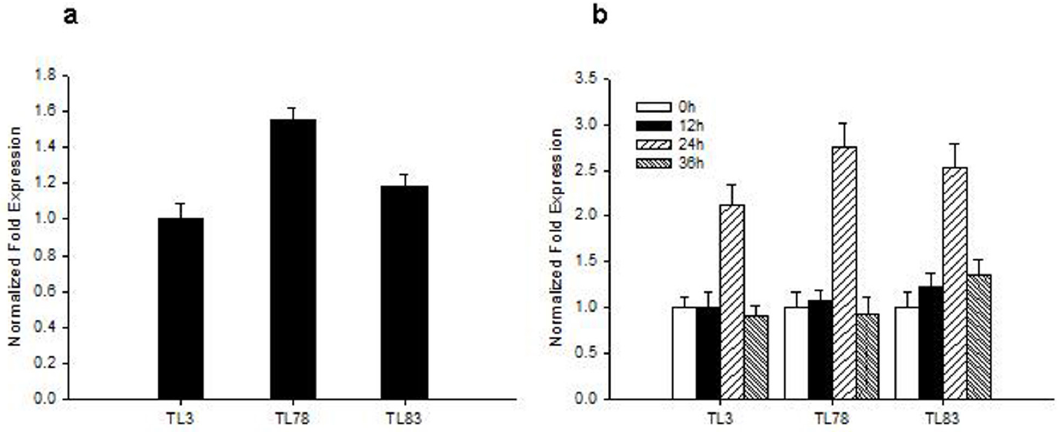
Figure 8. The expression of RsVPE1 gene in transgenic Arabidopsis flower buds. ( a ) RsVPE1 expression in transgenic plants under normal condition. The transcript level of RsVPE1 in TL3 was used as the calibrator; ( b ) RsVPE1 expression in transgenic plants subjected to heat stress. The transcript levels of RsVPE1 in three transgenic lines at 0 h heat stress were used as the calibrators, respectively. TL3, TL78, TL83 are homozygous transgenic lines. Error bars represent the mean ± SD of three independent biological